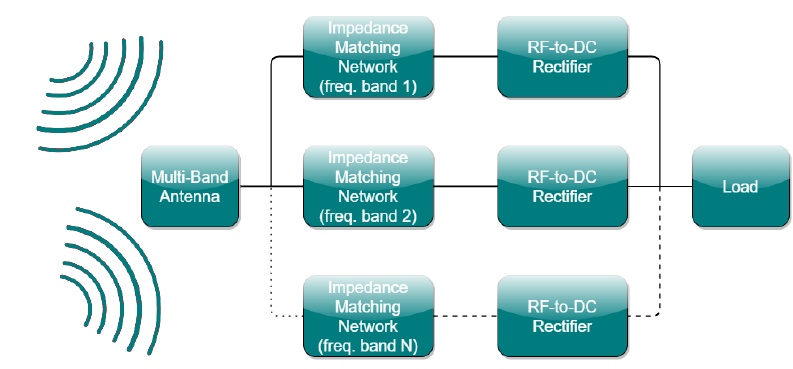
Figure 1. Typical multiband rectenna block diagram.